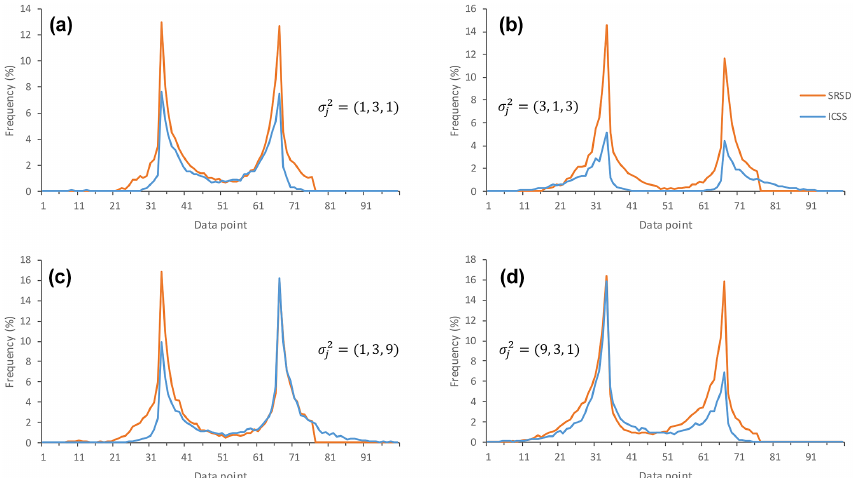
Figure 5. Results of Monte Carlo experiments with two change points c j = (34 , 67). The parameters of SRSD used in each of the experiments are given in Table 4. Table 4. Percentages of total numbers of change points detected by SRSD ( p , 25, h ) and ICSS in each series on average in the case of two true change points c j = (34 , 67). The corresponding frequency distributions of the detected change points are presented in Fig. 5.